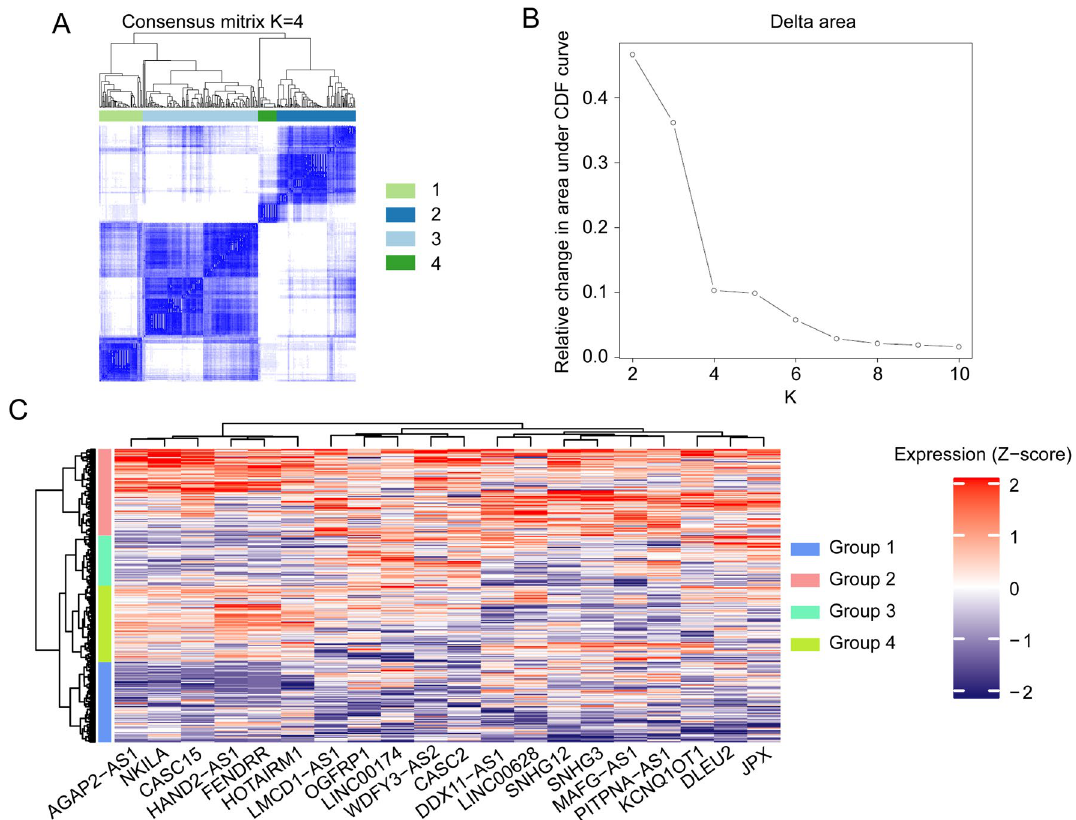
Figure 1. Consensus clustering of HCC samples based on 20 lncRNAs related to immune disorders. ( A ) The consensus clustering map when K = 4. ( B ) K = 4 was considered the optimal number of clusters. ( C ) Heatmap of expression of the 20 immune-related lncRNAs among the different